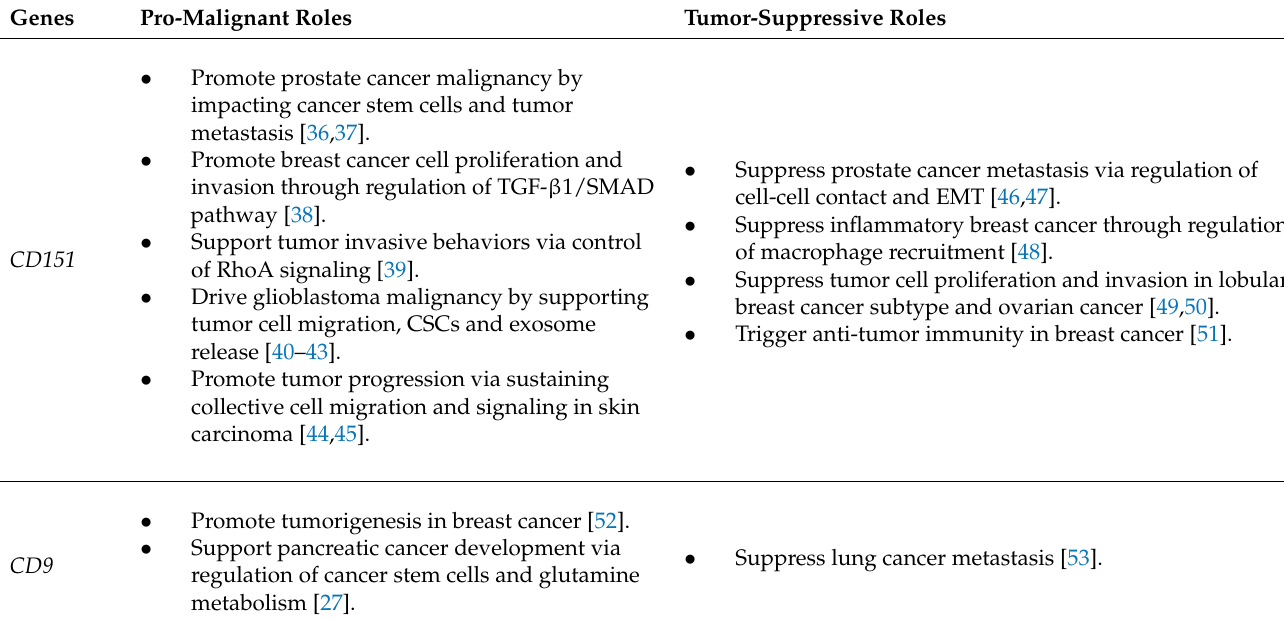
A glance of tumor-promoting and suppressing roles of tetraspanin molecules across human epithelia- origin cancers